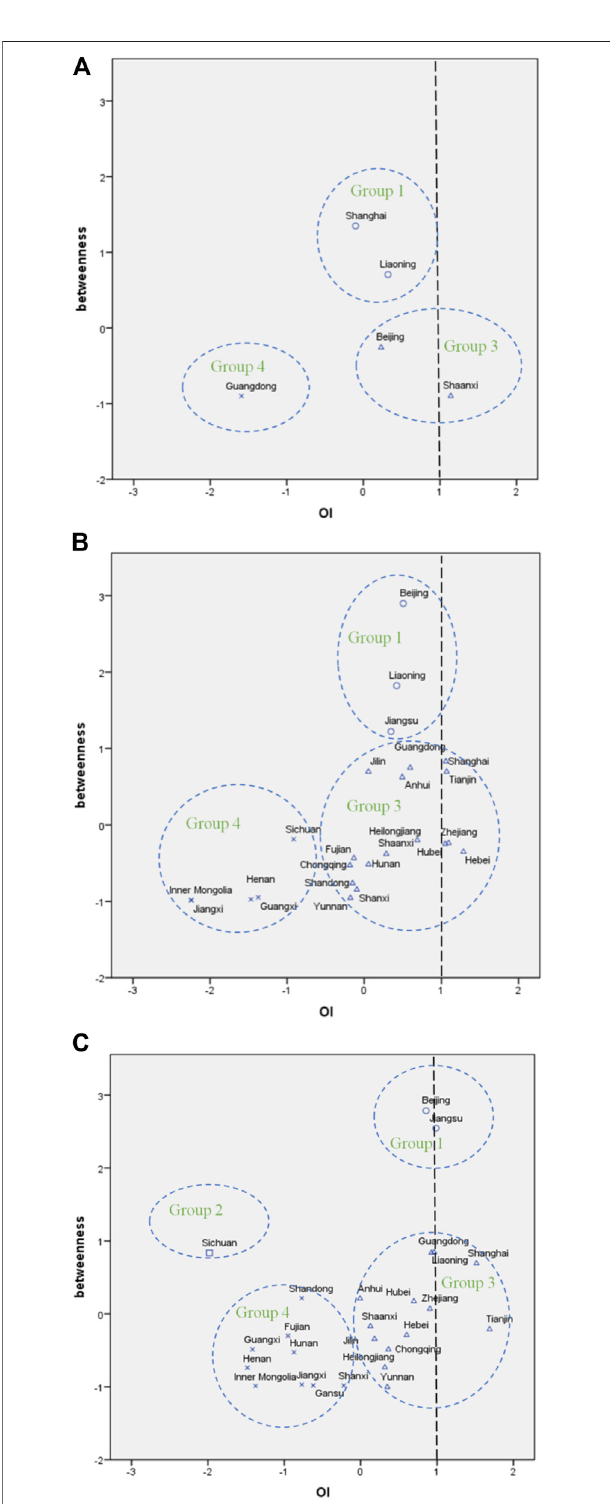
FIGURE 6 | Position of Chinese provinces in China ’ s HFCV innovation network. Note: circle: Group 1, square: Group 2, triangle: Group 3, cross: Group 4. (A) (2001 – 2006), (B) (2001 – 2016), (C) (2001 –